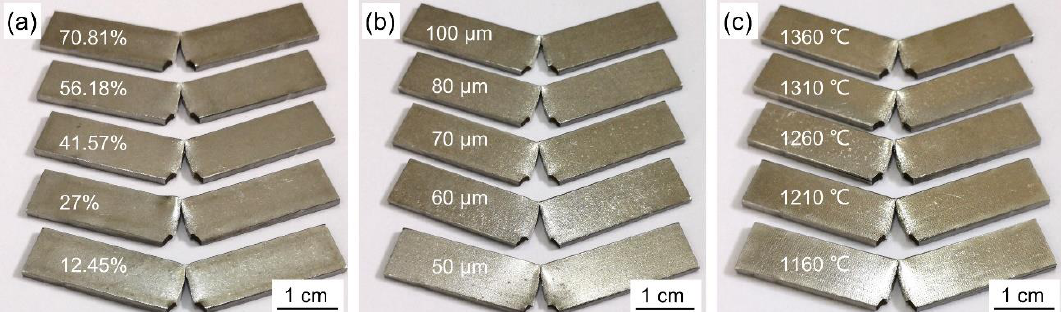
Figure 6. Macrograph of PWMCPPs after impact tests. ( a ) Different volume fractions; ( b ) different diameters; ( c ) different sintering temperatures.